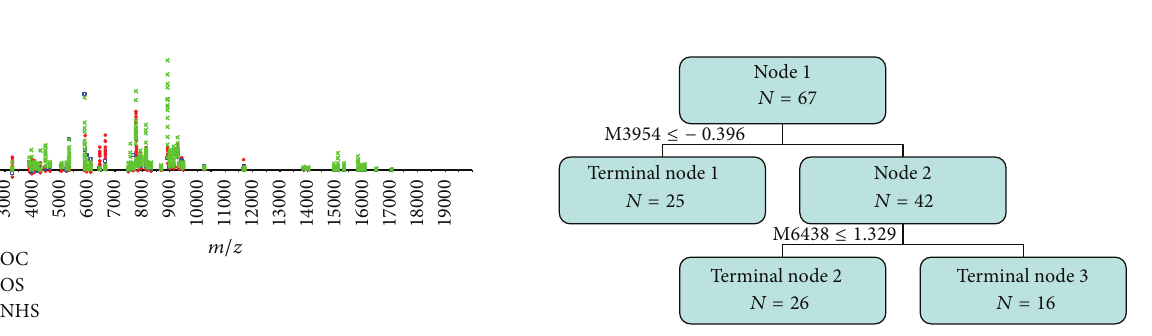
Figure 2: The protein intensity of osteochondroma (OC), osteosar- coma (OS), and normal human serum (NHS). The protein intensity of the serum samples from NHS (green panel), OS (blue panel), and OC (red panel).